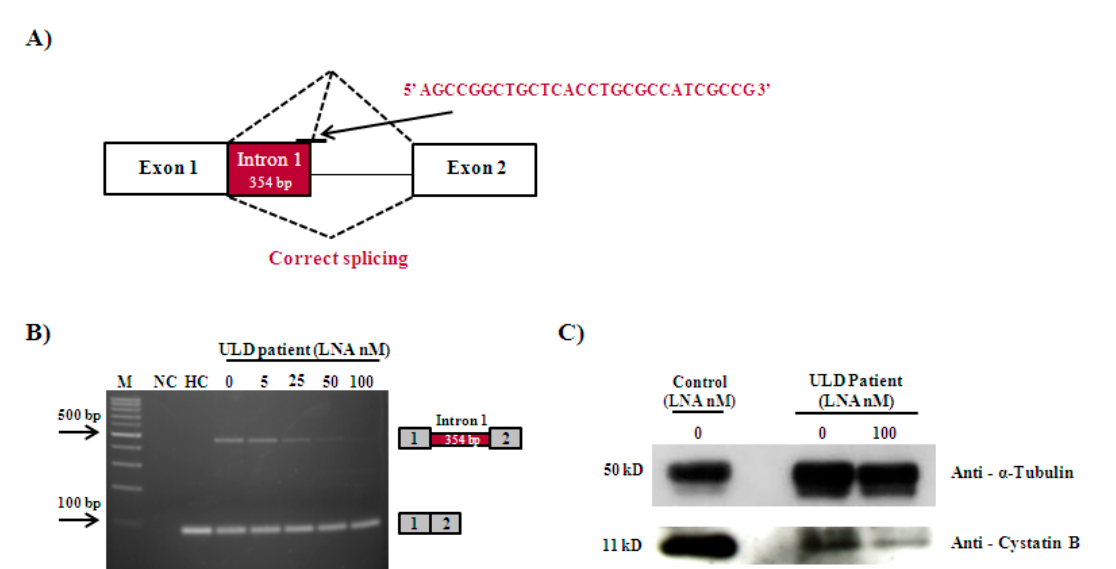
Figure 2. Antisense locked nucleic acid (LNA) therapeutic approach in Unverricht-Lundborg disease (ULD), patient-derived fibroblasts. ( A ) Schematic representation of the splicing downregulation observed in the presence of the c.66G>A CSTB mutation. The sequence of the LNA complementary to the cryptic donor site activated by the mutation and designed in order to block the recognition of the intronic alternative 5 ′ ss in fibroblasts from the patient is shown. ( B ) Transcriptional profile obtained for HC and patient fibroblasts untreated (0 nM) and treated with quantities between 5 to 100 nM of LNA oligonucleotide. The RT-PCR analysis showed the disappearance of the aberrantly spliced transcript (451 bp) when cells were treated with 100 nM of the LNA oligonucleotide. Correctly spliced mRNA was obtained 24 h after transfection in a dose-dependent manner. ( C ) CSTB protein expression in control and patient fibroblasts untreated (0 nM) and treated with 100 nM of the LNA. The α -tubulin protein was used as loading control. M—molecular marker; NC—negative control; HC—healthy control.